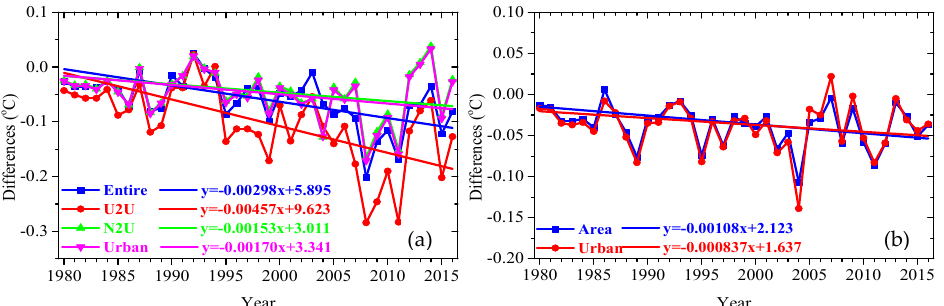
Figure 7. Time series of the differences in urban-related warming between T 4 and T xn (T xn minus T 4 ) and the corresponding trends over different subregions (i.e., the whole area, U2U, N2U, and urban areas) of ( a ) Guangzhou and ( b ) Shenzhen.